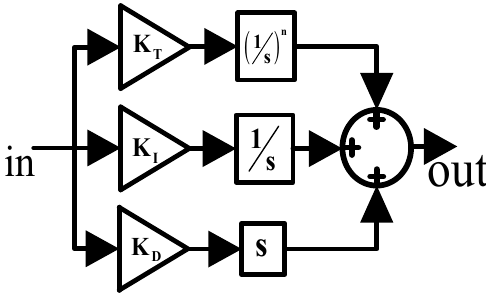
Figure 8. Block diagram of a TID controller.